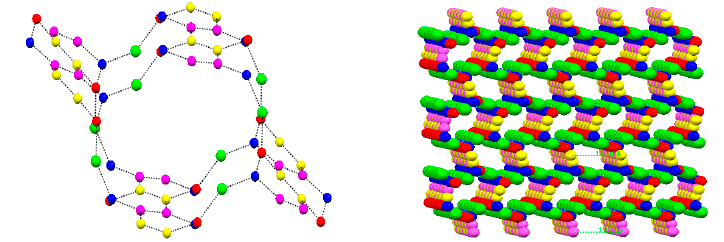
Figure 2. ( Left ) The formation of the water cluster cavity; ( Right ) View of the nanometer-sized water cluster conduit in the a axis. The Cl atoms are detained and [CuCl(phen) (H 2 NCH 2 COO)] is omitted for clarity. Colors are as follows: blue, O1w; red, O2w; pink, O3w; yellow, O4w; Green, Cl atom. Table 1. Geometrical parameters of hydrogen bonds (Å, deg) for the water cluster.